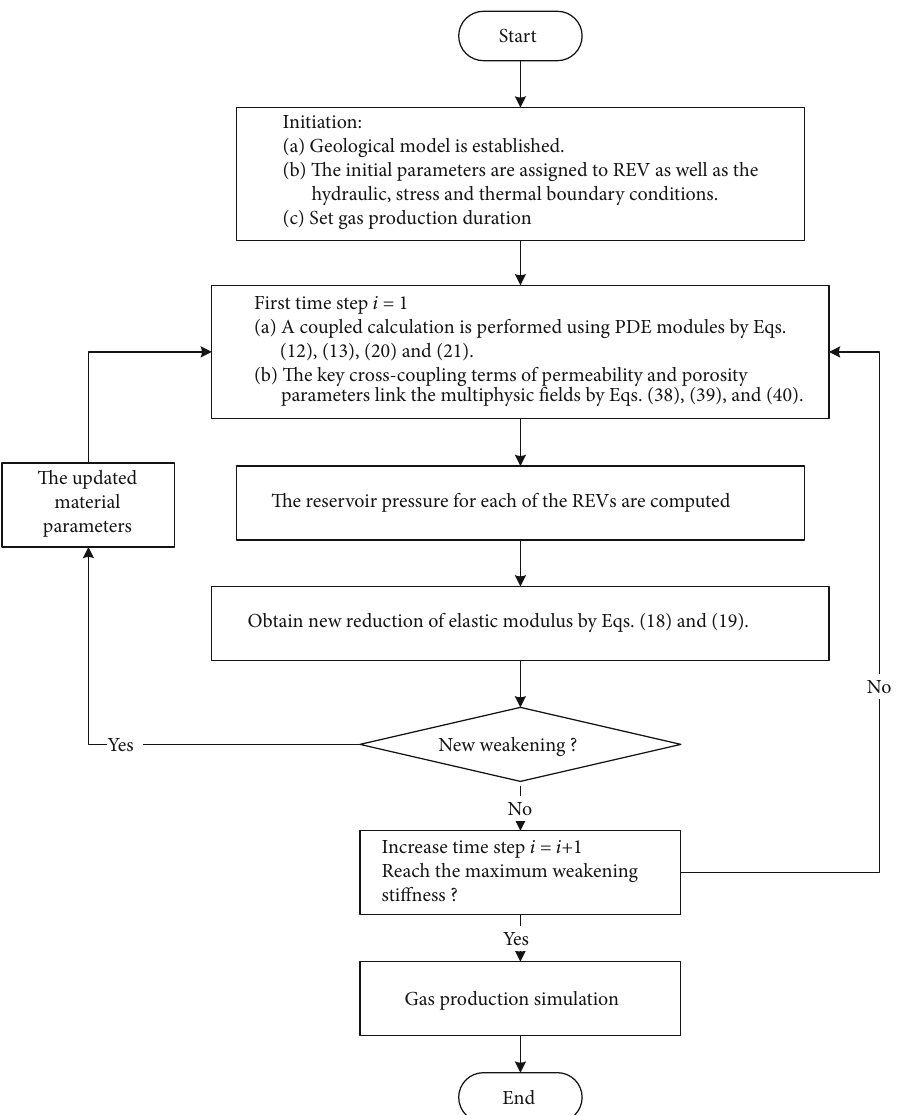
Figure 3: Solving process of THM coupled model for primary/ECBM